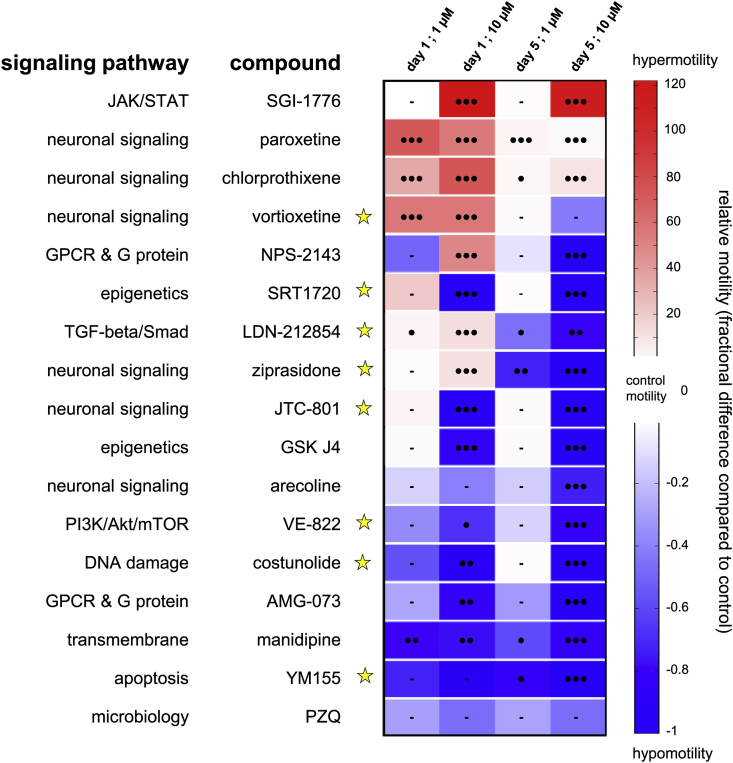
Motility assay on schistosomulae treated with secondary screened compounds.Heat map of all secondary screened compounds. Three-day old schistosomulae were treated with 1 and 10 μM of each compound and motility was calculated relatively to control animals (DMSO-treated). Blue and red colors correspond to hypo- and hypermotility respectively. Viability <50% after five days is represented as a yellow star. Black circles indicate p value < 0.0005 (3), <0.005 (2), <0.05 (1). Bars represent no significant change in motility rate compared to control.(For interpretation of the references to color in this figure legend, the reader is referred to the Web version of this article.)